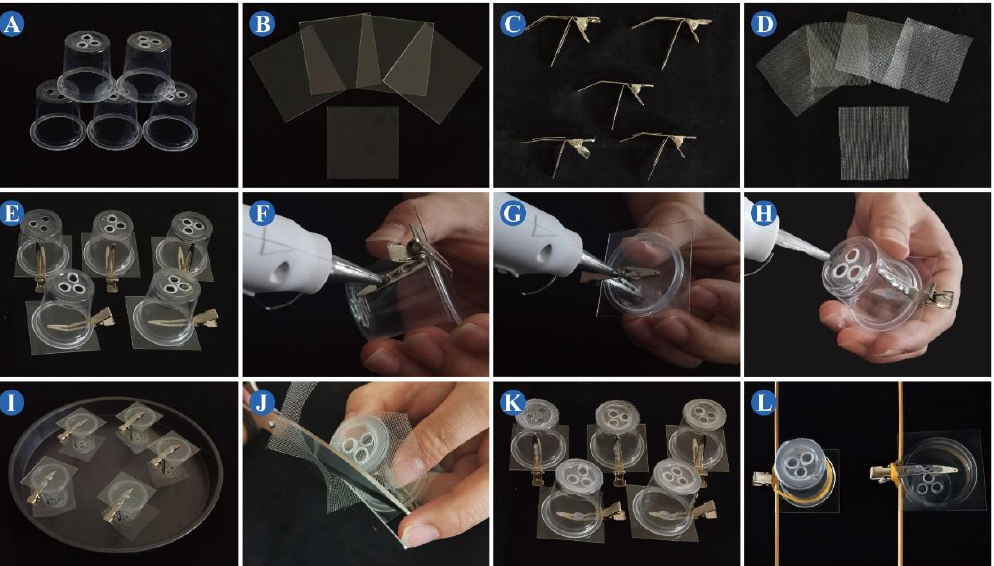
Figure 1. Process of making clip cages. ( A ) Plastic cups with holes in the bottom. ( B ) Cropped polyvinyl chloride sheets. ( C ) Bent duck-bill clips. ( D ) Cut nylon organdy mesh. ( E ) Assembly of materials in ( A – C ). ( F ) Apply hot melt glue to the junction of the clip and the plastic cup. ( G ) Glue the clip to the polyvinyl chloride sheet. ( H ) Apply a ring of hot melt glue to the bottom of the cup. ( I ) Seal the clip cage with nylon organdy mesh placed on a non-stick pan. ( J ) Trim the edges of nylon organdy mesh. ( K ) Finished clip cage. ( L ) Clip cage assembled with elastic bands and bamboo skewers.